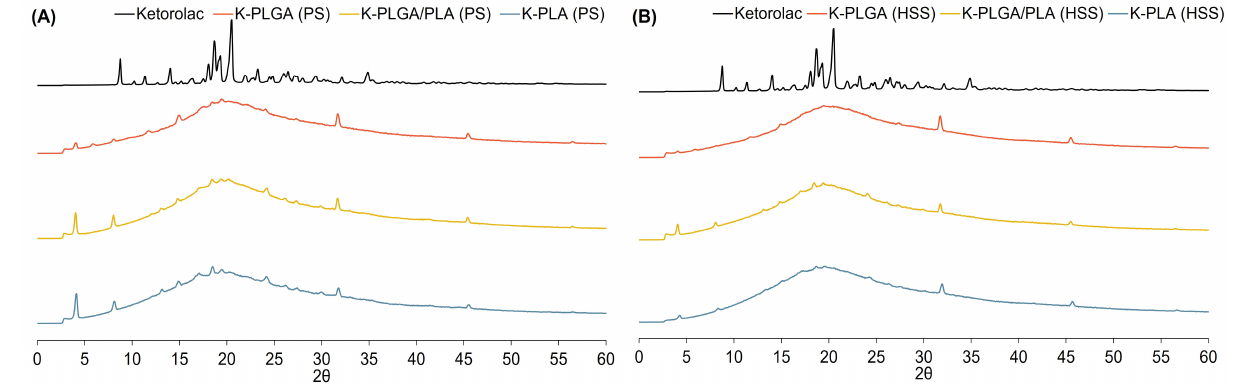
Figure 3. X ‐ ray diffractograms of ketorolac ‐ loaded microparticles (K ‐ PLGA, K ‐ PLGA/PLA, and K ‐ Figure 3. X-ray diffractograms of ketorolac-loaded microparticles (K-PLGA, K-PLGA/PLA, and PLA) prepared by PS ( A ) and HSS ( B ) methods. K-PLA) prepared by PS ( A ) and HSS ( B )